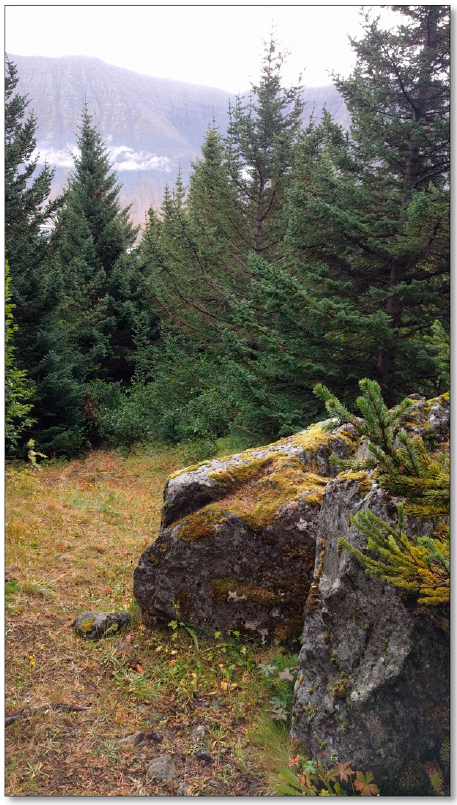
Figure 7. Forest site above Urðavegur.